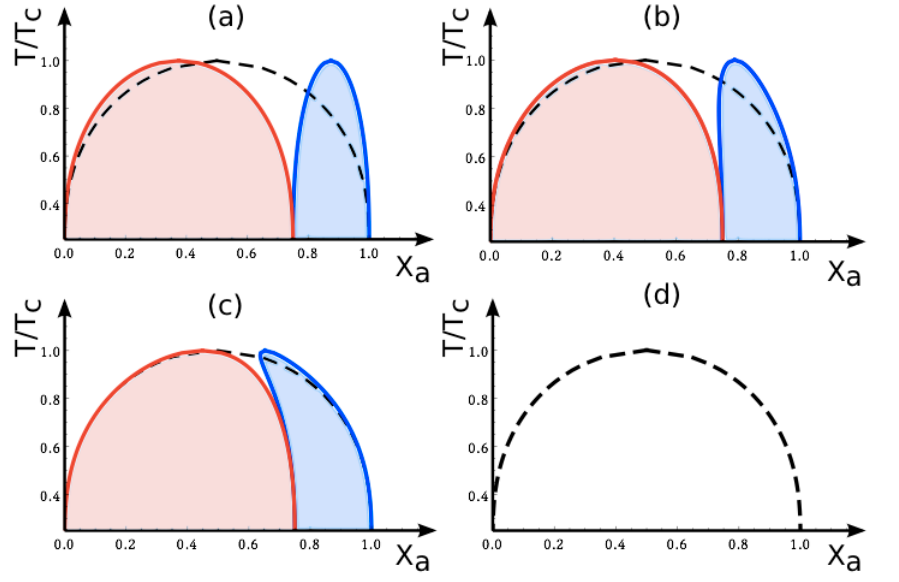
Figure 7. Mean-field phase diagrams of the lattice model for adhering membranes as a function of mole fraction X a and reduced temperature T/T c for fixed area fraction q = 0 . 25 . The different subfigures correspond to different negative values of the reduced affinity contrast ¯ U 2 , 1 ≡ U 2 , 1 / ( k T ) : ( a ) ¯ U 2 , 1 = − 5 , ( b ) ¯ U 2 , 1 = − 0 . 5 , ( c ) ¯ U 2 , 1 = − 0 . 05 , and (d) ¯ U 2 , 1 = 0 . Inspection c B of these subfigures shows that the blue and red coexistence regions for the two membrane segments change smoothly as the affinity contrast is increased from large negative to small negative values. Furthermore, in the limit of vanishing affinity contrast, the two coexistence regions merge into the single region for the uni-env membrane as described by the broken black lines in ( a – d